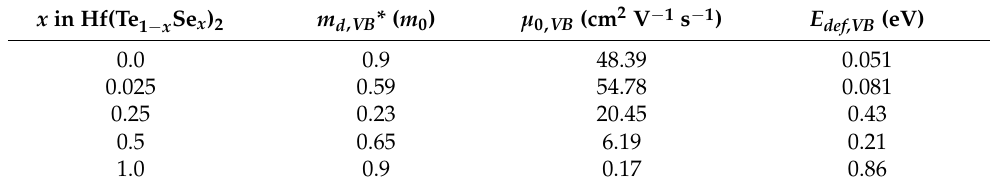
Table 2. The m d,VB *, μ 0 , VB , and E def,VB for Hf(Te 1 − x Se x ) 2 ( x = 0.0, 0.025, 0.25, 0.5, and 1.0) at 300 K.